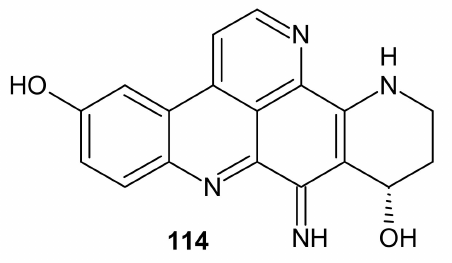
Figure 31. Calliactine